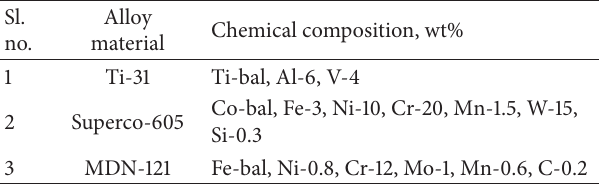
Table 1: Chemical compositions of the substrates used for HVOF coatings.